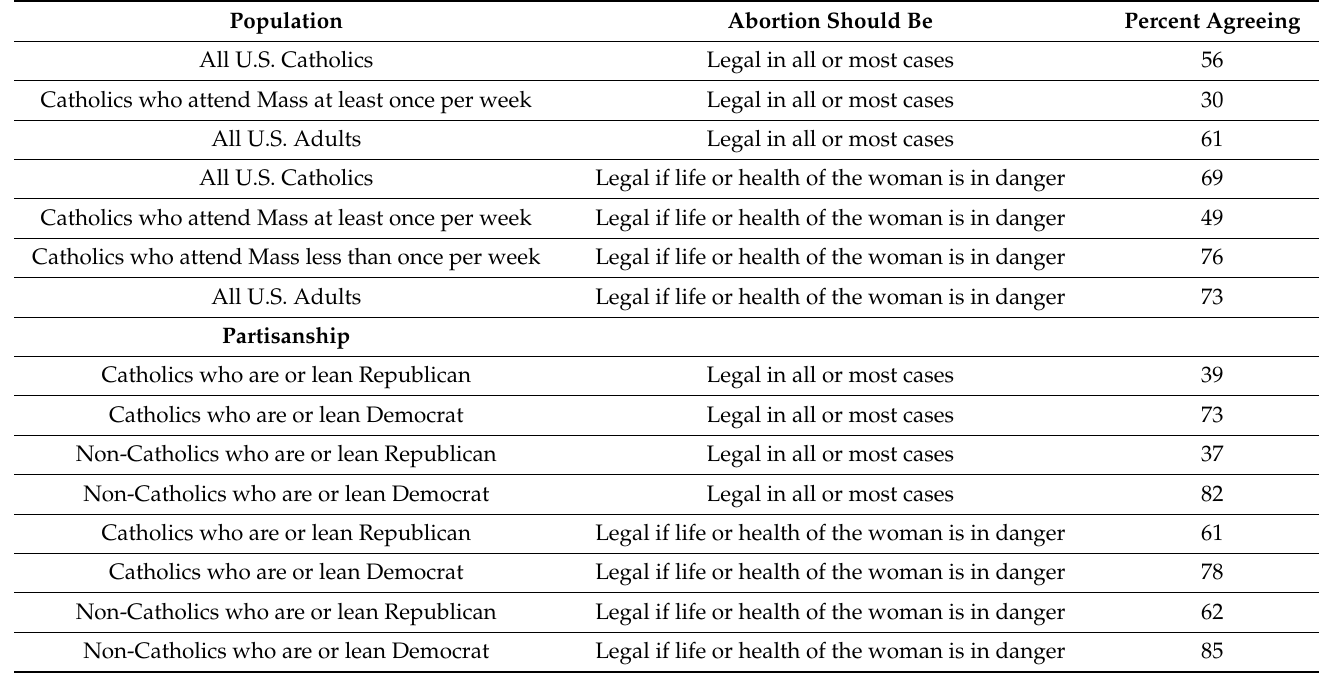
Table 2. US Views on Abortion by Political Party and Catholic Identity. Population Abortion Should Be Percent